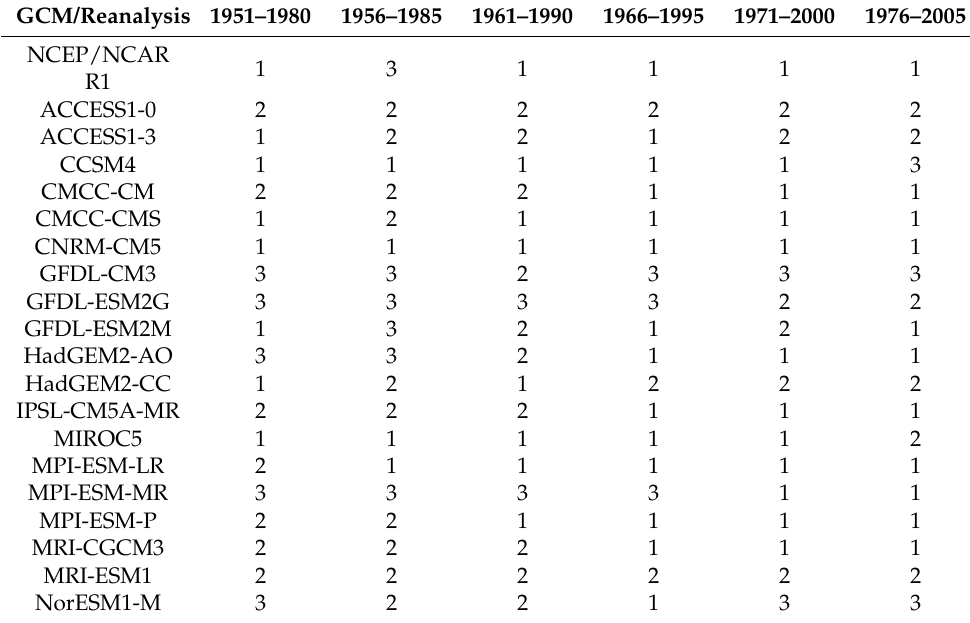
Table 3. Classification of the most similar CP maps. In the table, 1 is associated with the cases when the most similar CP maps contain only type 1 clusters; 2 indicates that the most similar CP maps incorporate at least one corresponding cluster that is among the most frequently observable clusters but not the nearest cluster; 3 could mean either at least one of the clusters that correspond to the reference cluster is completely missing or it cannot be found in the most similar CP